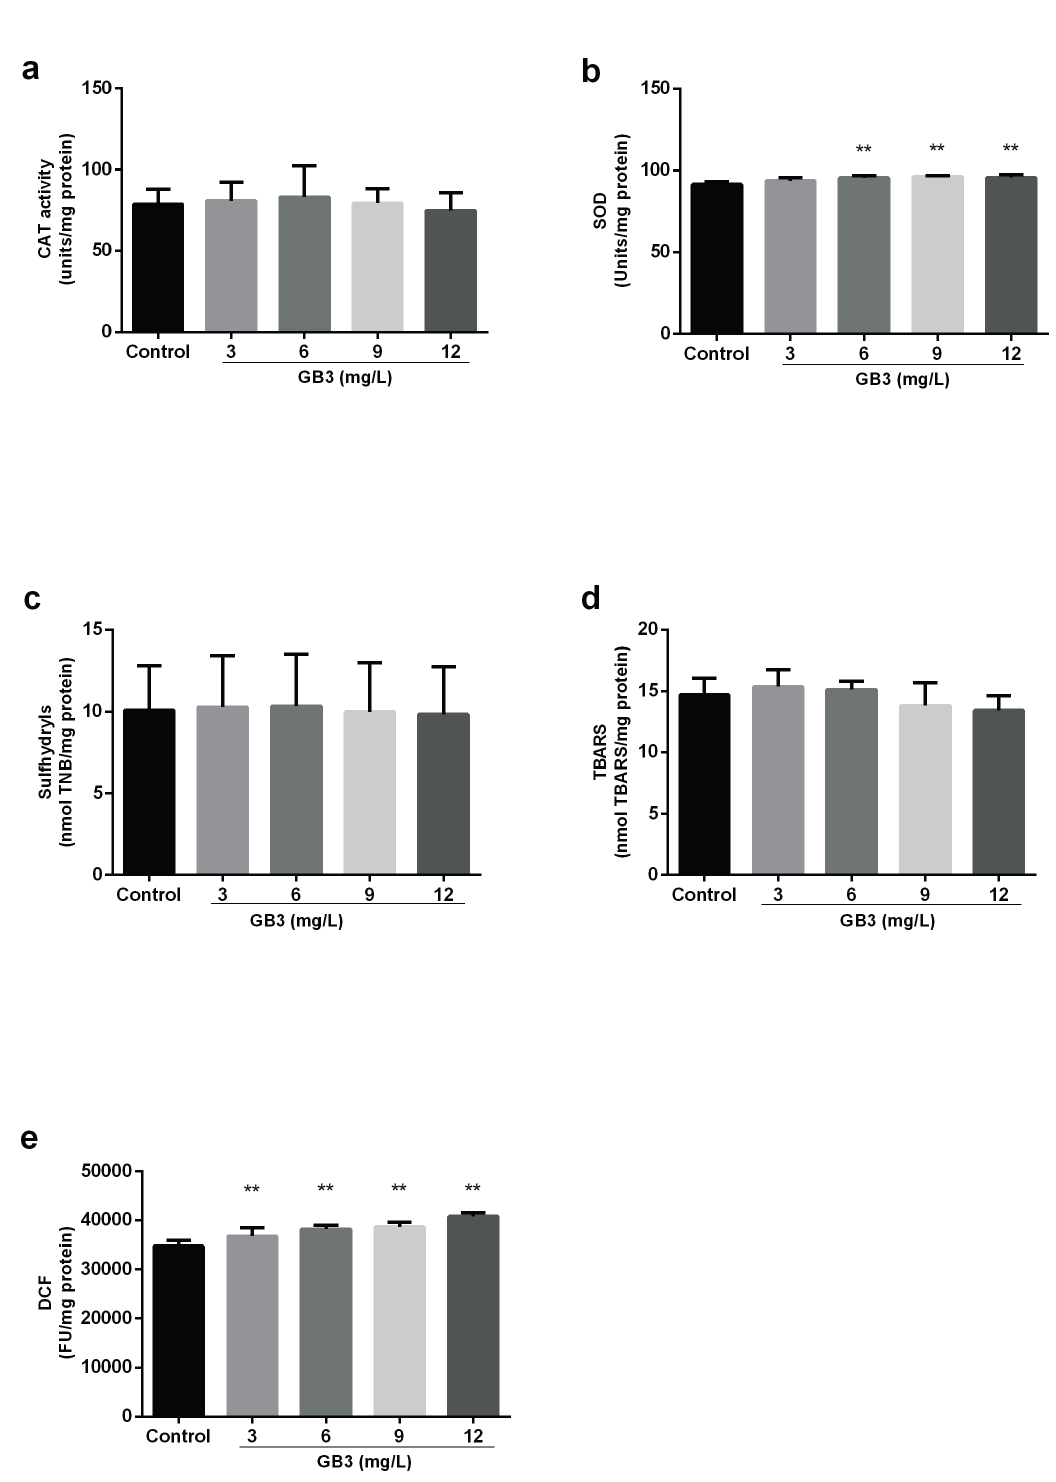
Figure 2 - In vitro effect of GB3 on catalase (CAT) activity ( a ), Superoxido dismutase (SOD) activity ( b ), sulfhydryl assay ( c ), lipoperoxidation ( d ) and production of reactive species ( e ) in kidney of Wistar rats. Values are means ± S.D. (n=6). Statistically significant differences from controls were determined by ANOVA followed by Tukey test: ** p <